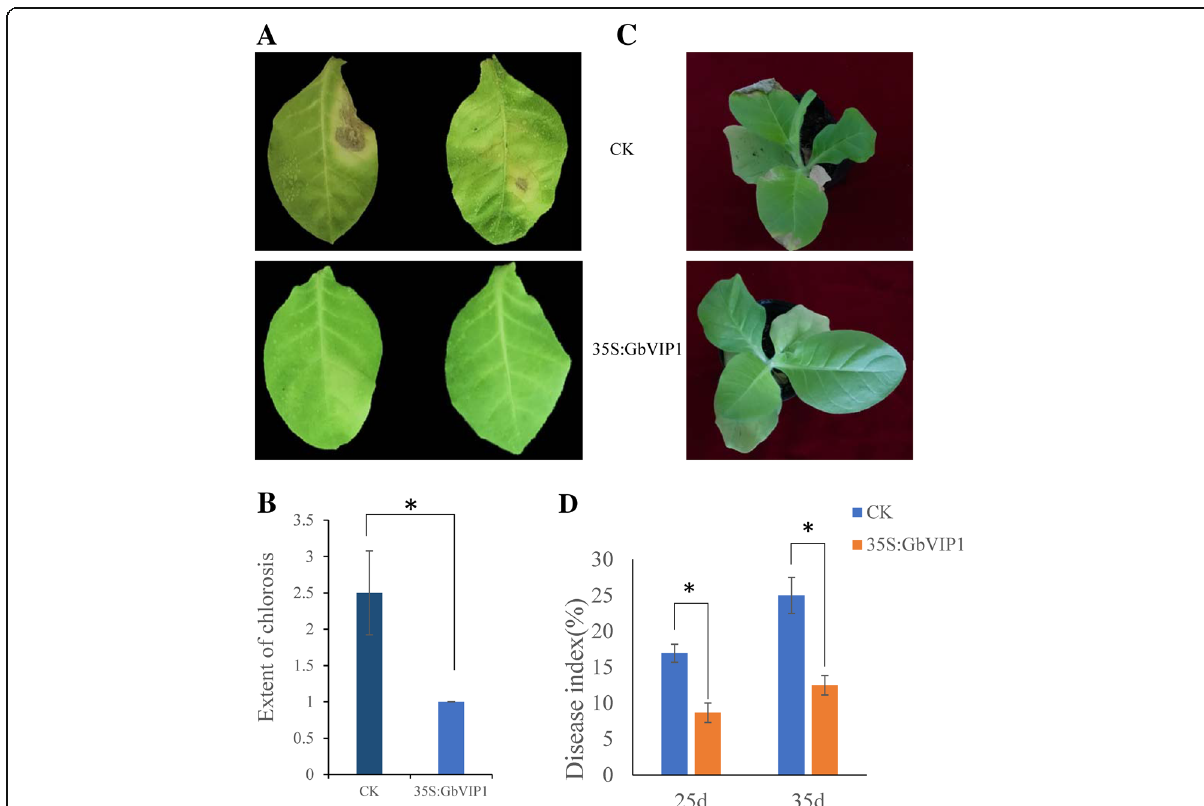
Fig. 5 GbVIP1 gene from cotton conferred resistance to Verticillium wilt in transgenic tobacco plants. a Disease phenotype of leaves from GbVIP1 transgenic tobacco and control at 16 days after inoculation with V. dahliae . 35S:GbVIP1 represents transgenic tobacco lines and CK represents the control tobacco lines. b Extent of chlorosis of leaves. c Whole plant disease phenotype of GbVIP1 transgenic tobacco and control at 25 days after infection of V. dahliae . d Disease index of GbVIP1 transgenic tobacco and control seedlings measured at 25 and 35 days after